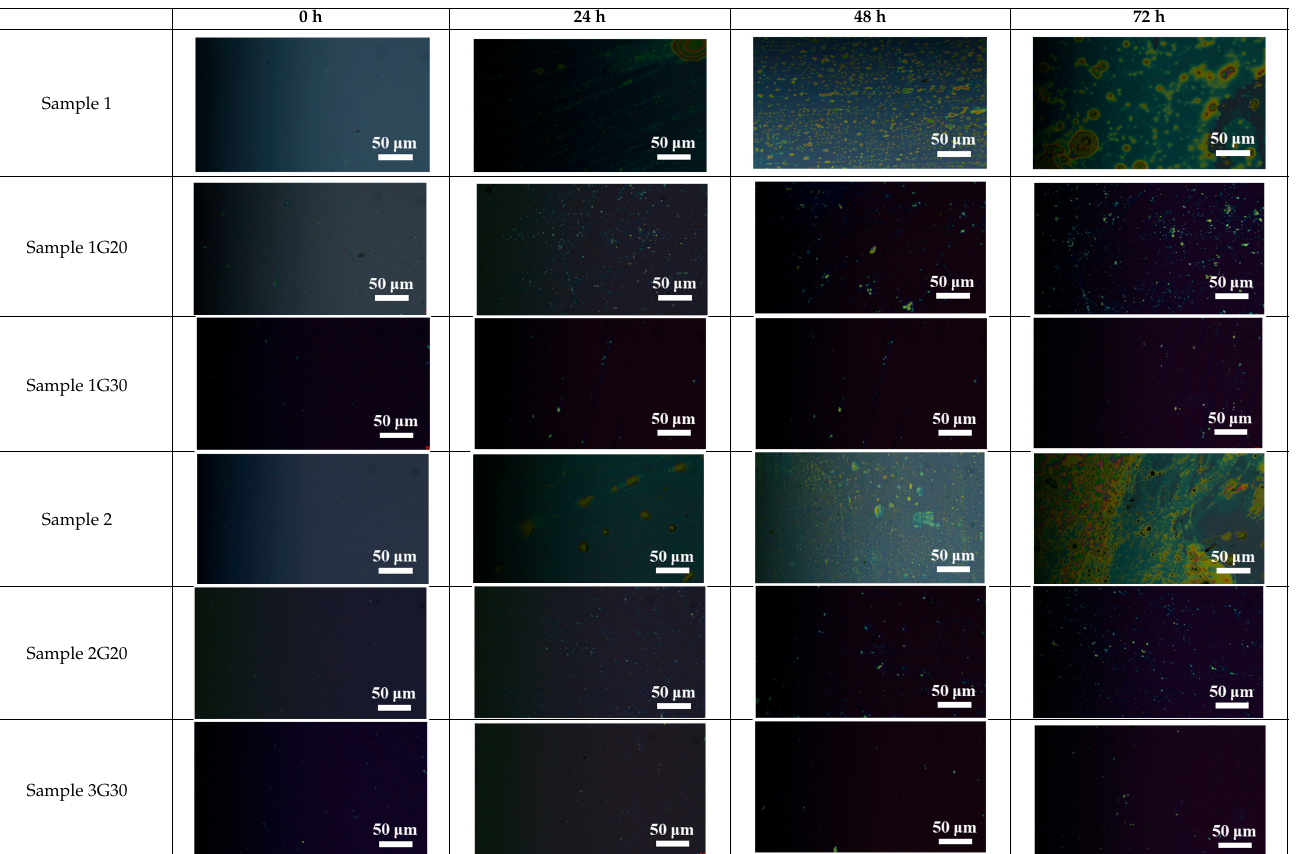
Table 1. Micrograph of ACF and G/ACF samples after salt spray test.